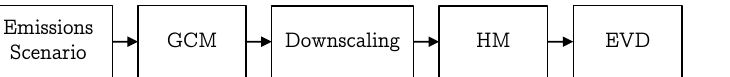
Figure 1. The multi-step modelling chain for generating future flood projections. General Circulation Models (GCMs) are forced under emissions scenarios, the outputs of which are downscaled to drive hydrological models (HMs). Extreme value distributions (EVDs) are then fitted to flood peak series in order to determine flood return